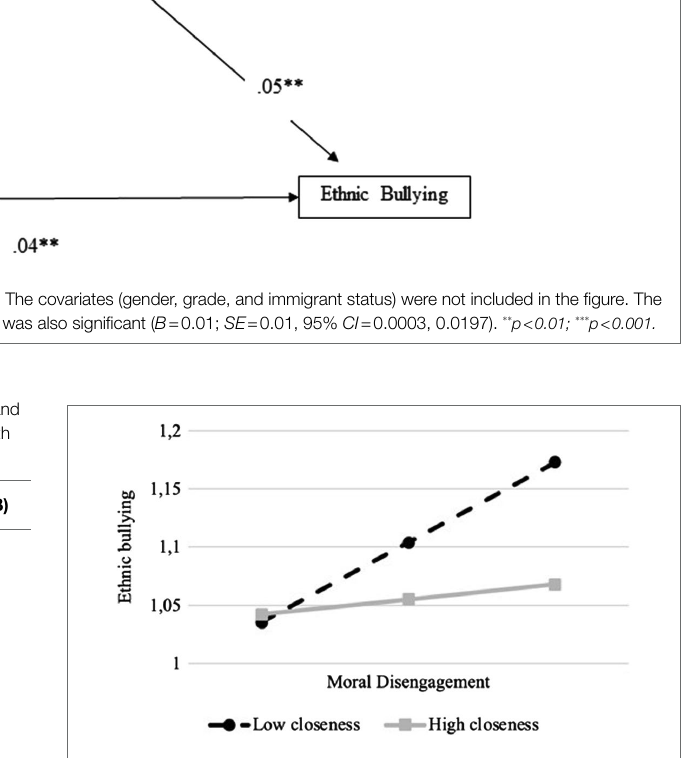
FIGURE 3 | Interaction between moral disengagement and closeness with the teacher on ethnic